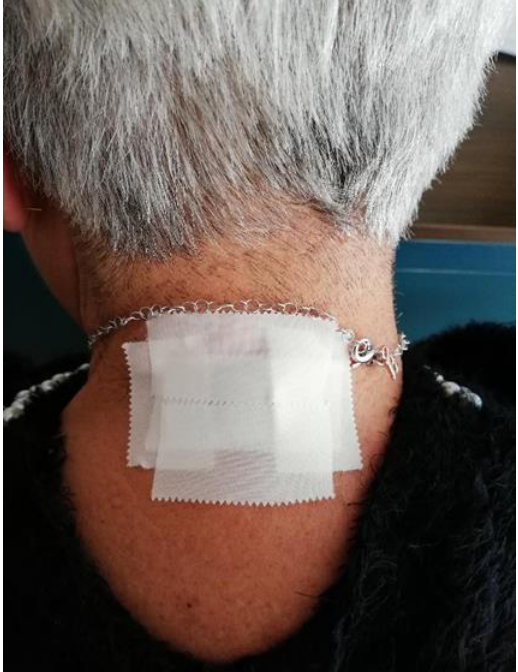
Figure 3 Standardized Model of Application of HO-ONP patch. Figure 3. Standardized Model of Application of HO-ONP